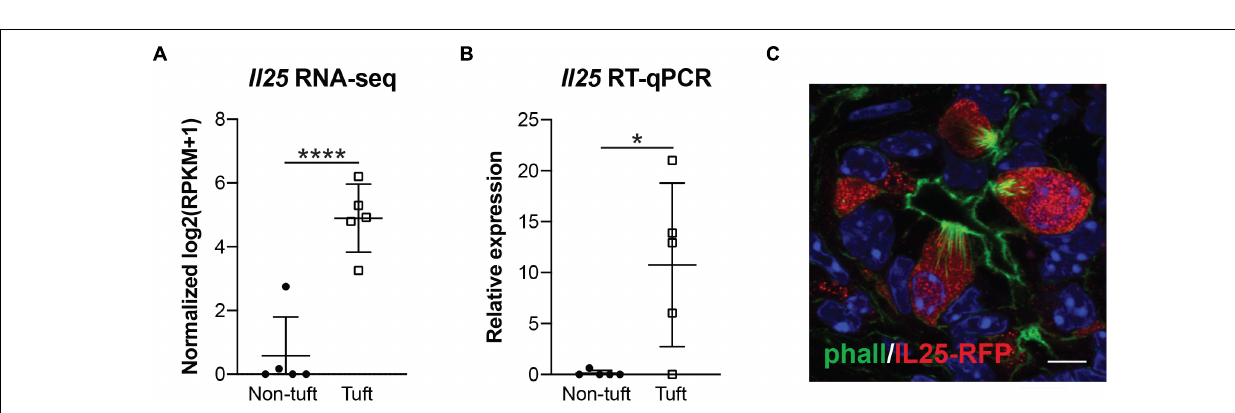
FIGURE 3 | Pancreatitis-induced tuft cells in wild type CD1 mice express cytokine IL-25. (A) RNA-seq demonstrating significantly higher expression of Il25 in tuft cells (EpCAM+; Siglec f+ cells) as compared to non-tuft epithelial cells (EpCAM+; Siglec f-neg cells). (B) RT-qPCR confirms significantly higher Il25 expression in tuft cells. (C) Co-immunofluorescence for red fluorescent protein (RFP, red) and phalloidin (green) in Il25 F 25 / F 25 mice with pancreatitis. Scale bar, 5 µ m. * p < 0.05; **** p < 0.001.